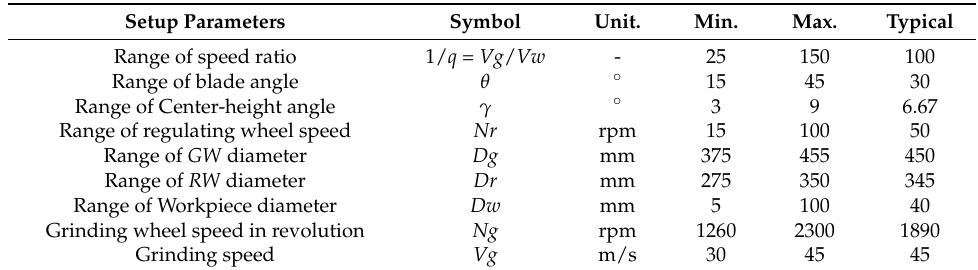
Table 2. Constraints of setup